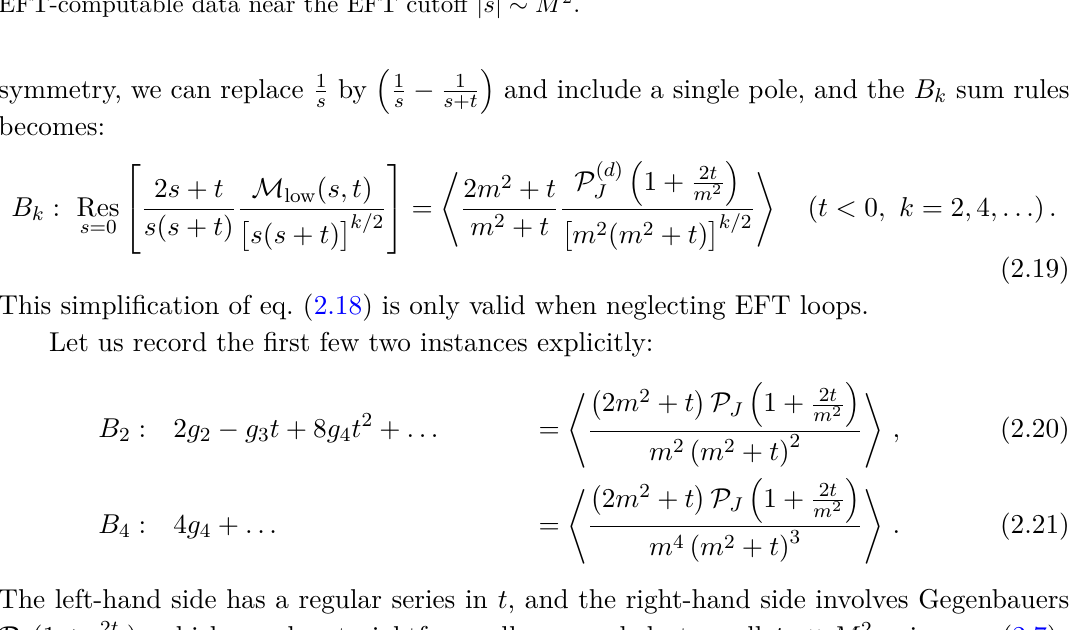
Figure 4. Integration contour to be used when low-energy loops are included; the integral vanishes as it is equivalent to arcs at infinity. This relates high-energy cuts at s > M 2 and u > M 2 with EFT-computable data near the EFT cutoff | s | ∼ M 2